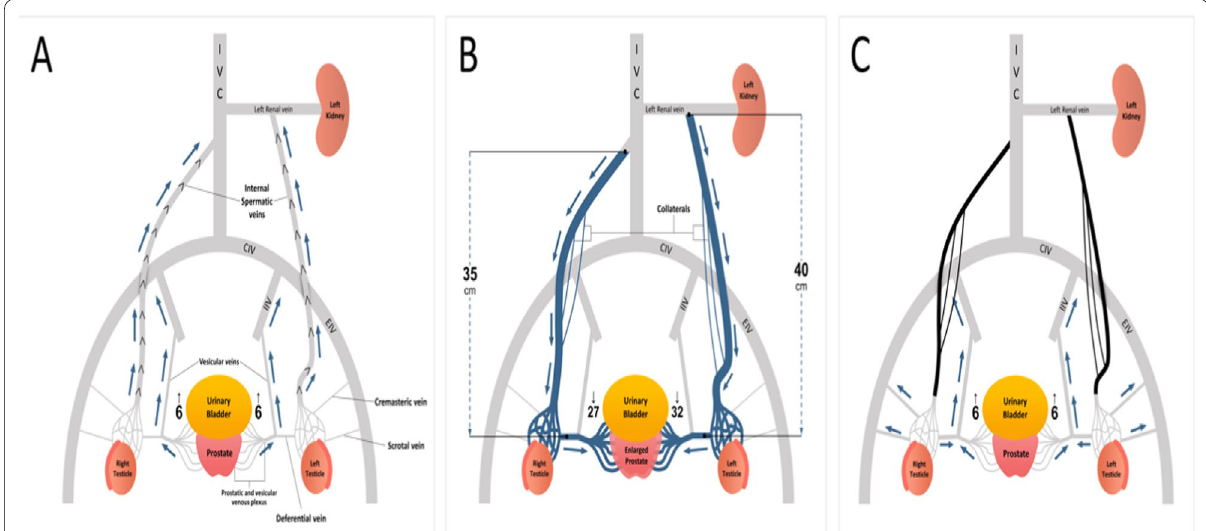
Fig. 1 Diagram showing A normal, B pathological and C post sclerotherapy testicular-prostatic venous changes with emphasis on the hydrostatic pressure changes for blood column lengths (EIV